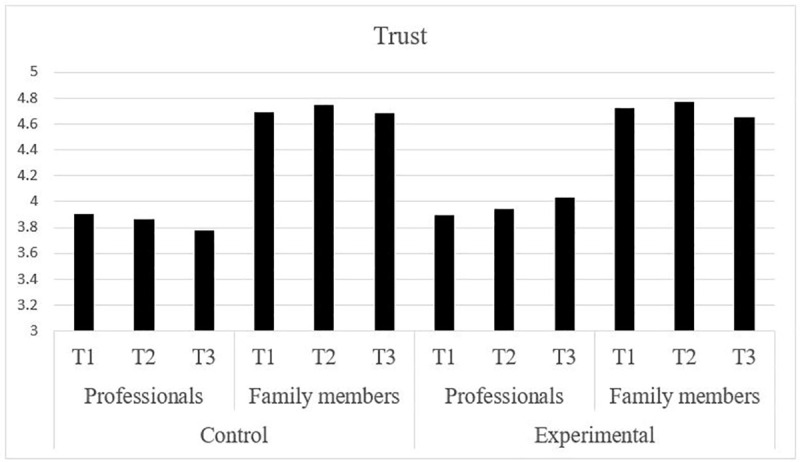
Trust of professionals and family members.